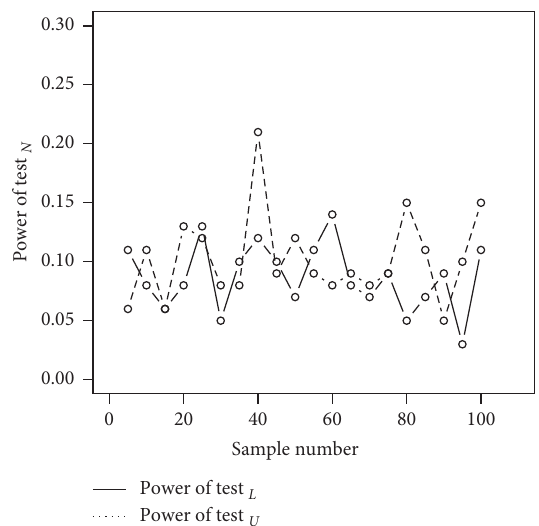
Figure 3: Power curve for the neutrosophic normal distribution.